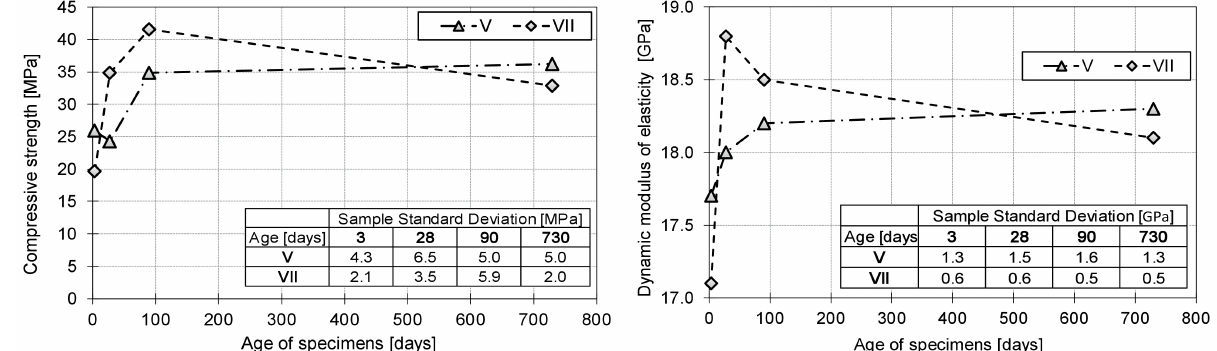
Figure 3. Development of the compressive strength (left) and the dynamic modulus of